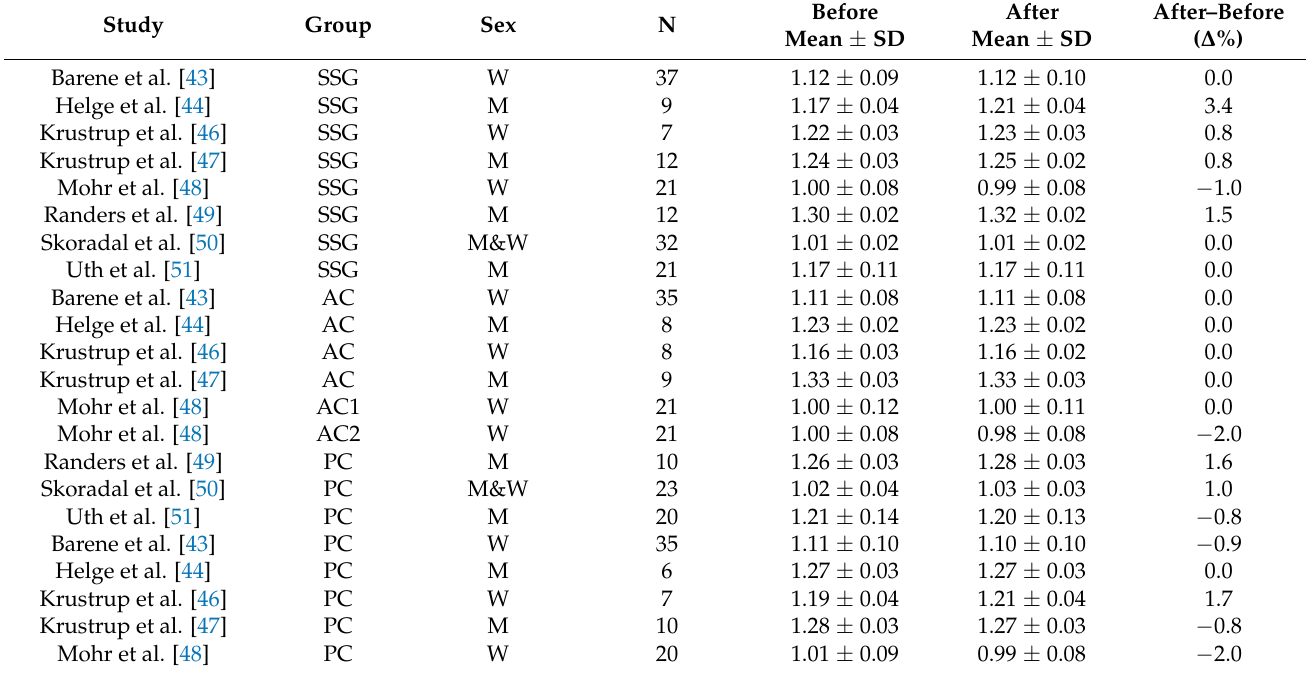
Table 6. Summary of the included studies and results of total body bone mineral density (BMD) before and after the intervention.